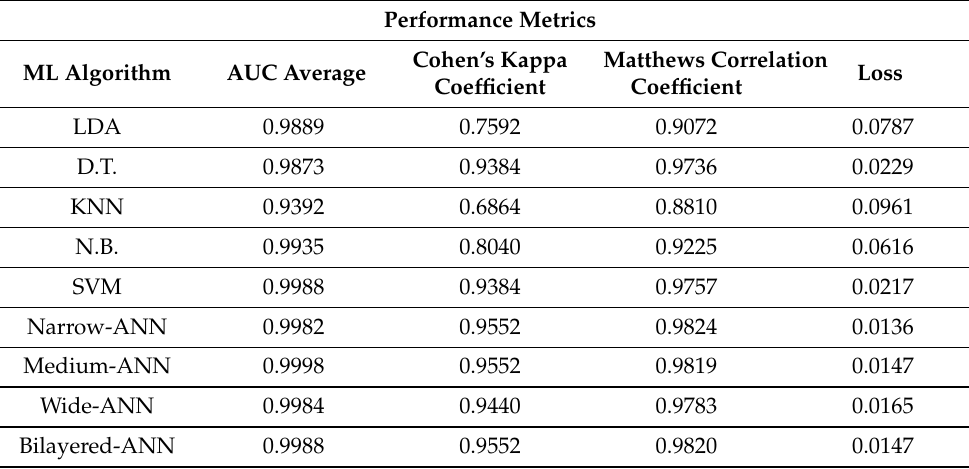
Table 5. Performance metrics of the nine ML algorithms trained for EEG signal